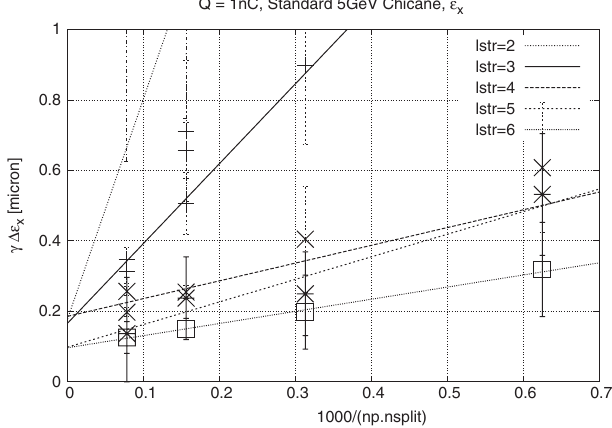
FIG. 17. Dependence on 1 =N p =n tal emittance growth (cid:4) (cid:1) (cid:1) x , for various values of string length l , for a ribbon beam, with (cid:4)(cid:1) y ¼ 0 : 01 mm mr . For these str simulations the string height h Extrapolation to the origin (infinitesimal charge per